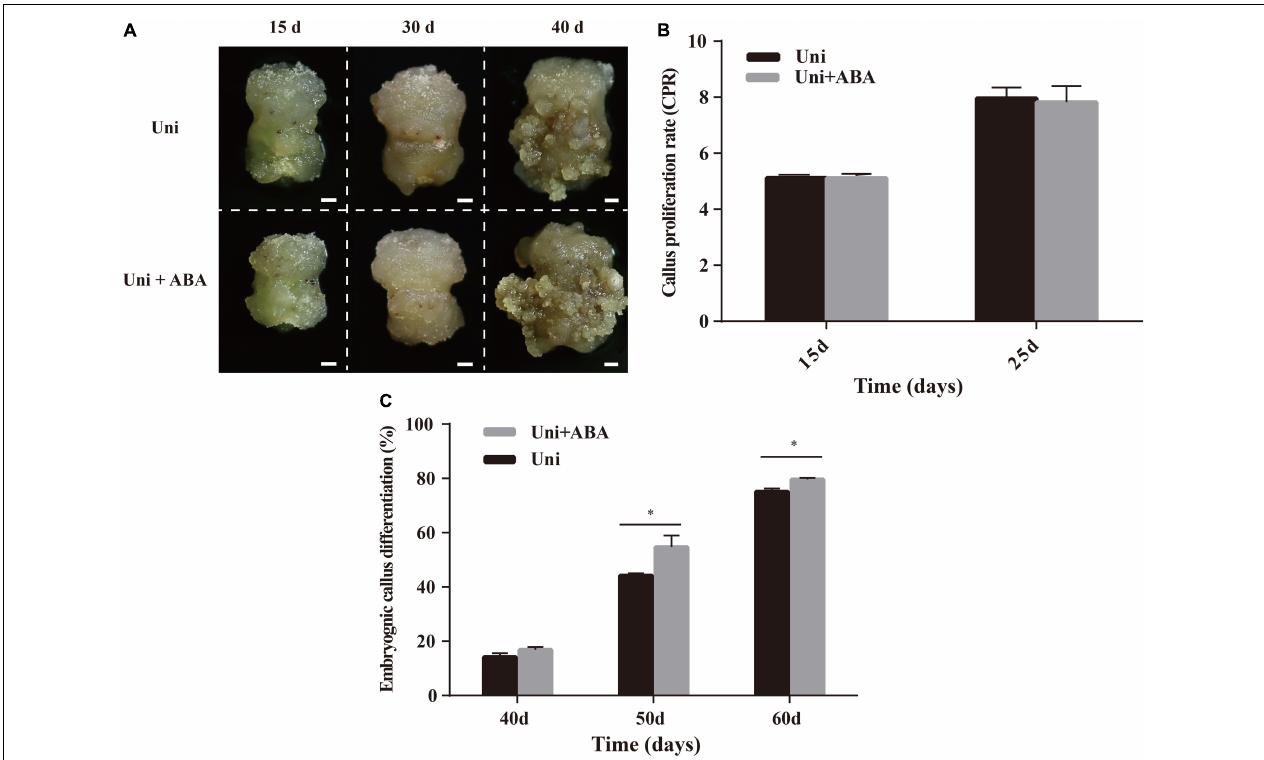
FIGURE 4 | Effects of exogenous uniconazole (Uni) and ABA on the conversion of callus to EC in ZM24. (A) Status of callus and EC after 15-, 30-, and 40-day induction on callus induction medium containing Uni or both Uni and ABA. Scale bar = 2 mm. (B) The CPR of ZM24 after induction for 15 and 25 days. (C) The embryonic differentiation rate (EDR) of ZM24 after induction for 40, 50, and 60 days. The single asterisk indicates statistical significance at p <